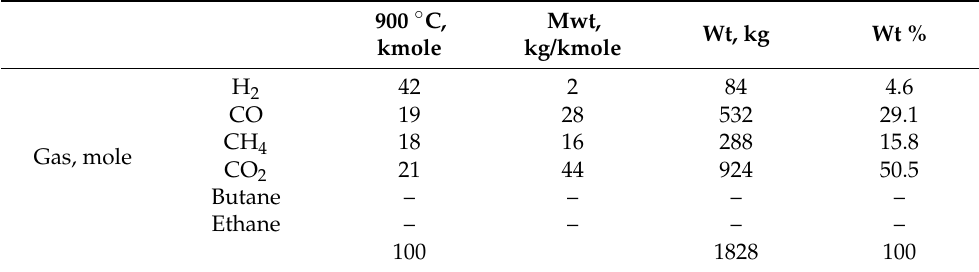
Table 28. Converting mole per cent to weight per cent—pyrolysis at 900 ◦ C.